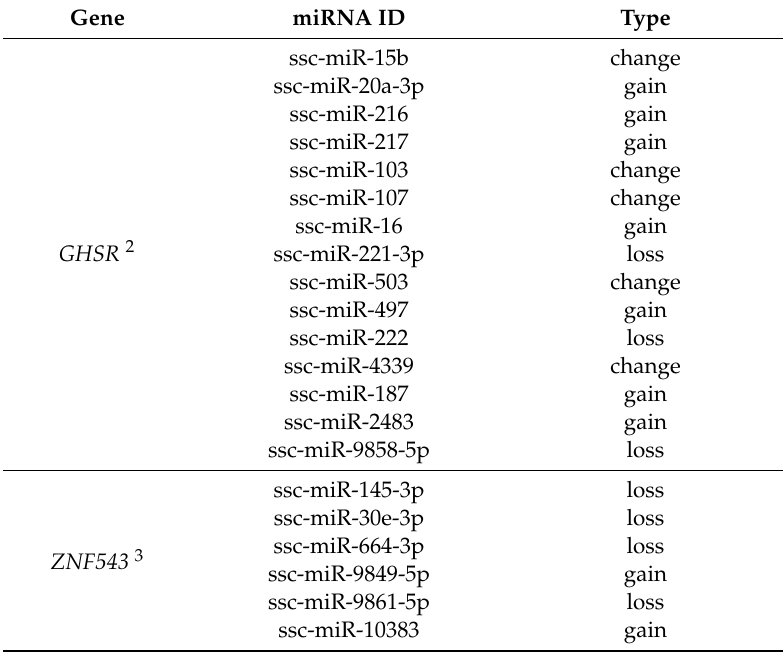
Table 3. miRNAs 1 that represent differential binding ability to different type of editing sites.